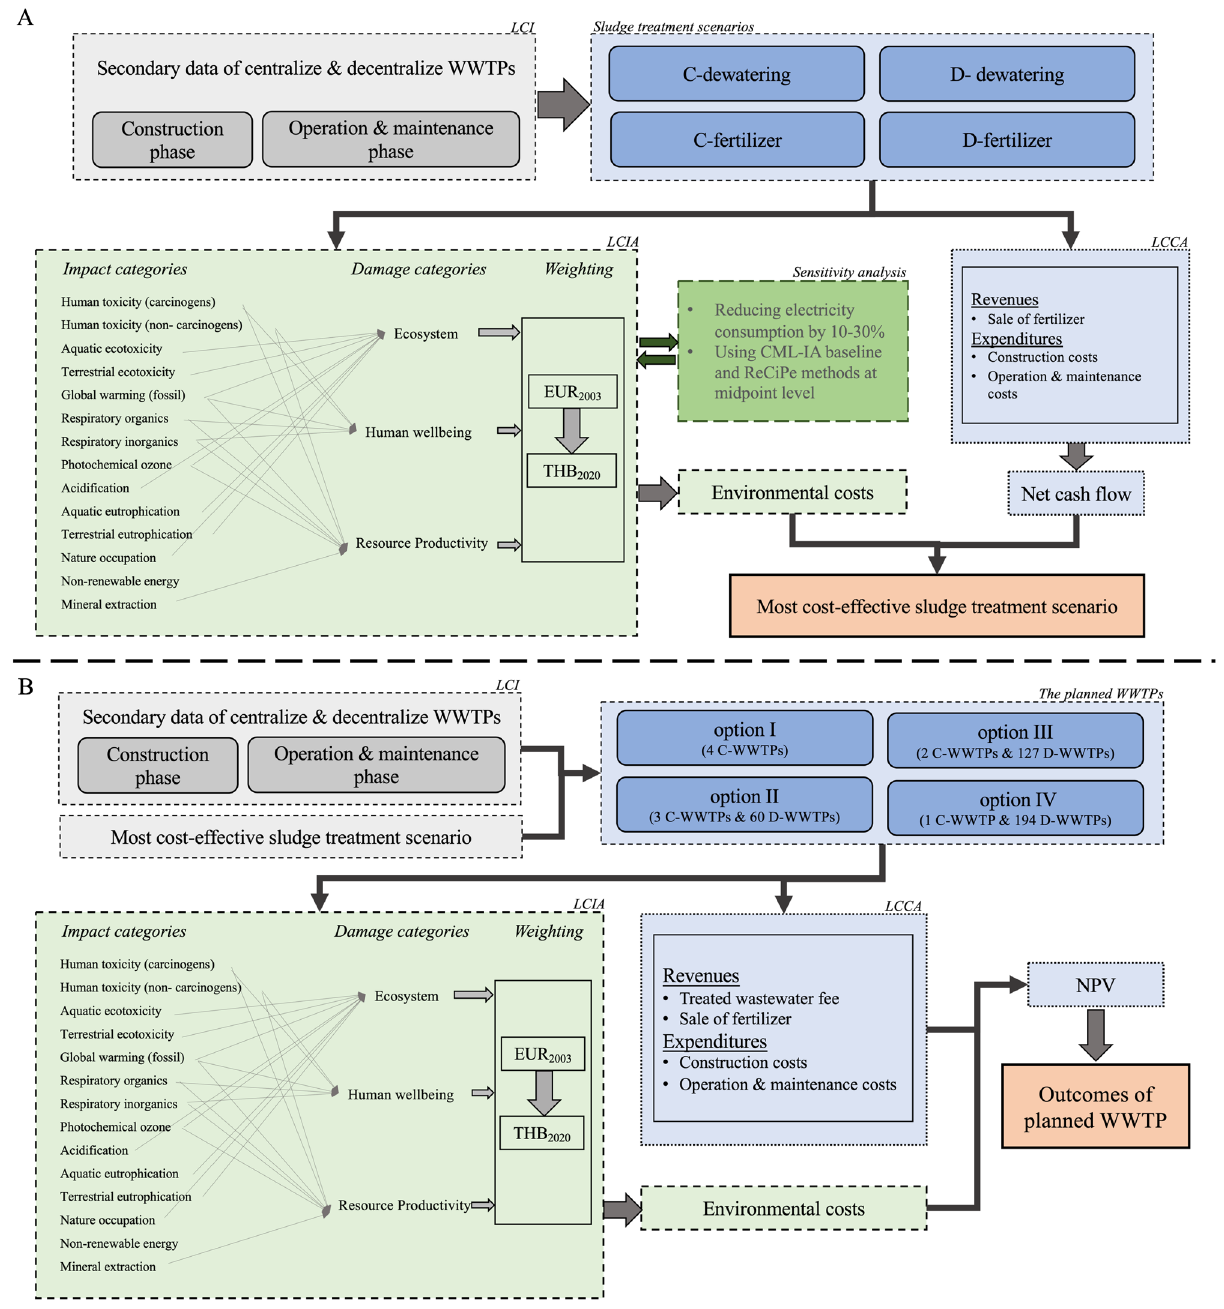
Figure 1. The overall research framework and methodology of (A.) four sludge treatment scenarios and (B.) four WWTP construction